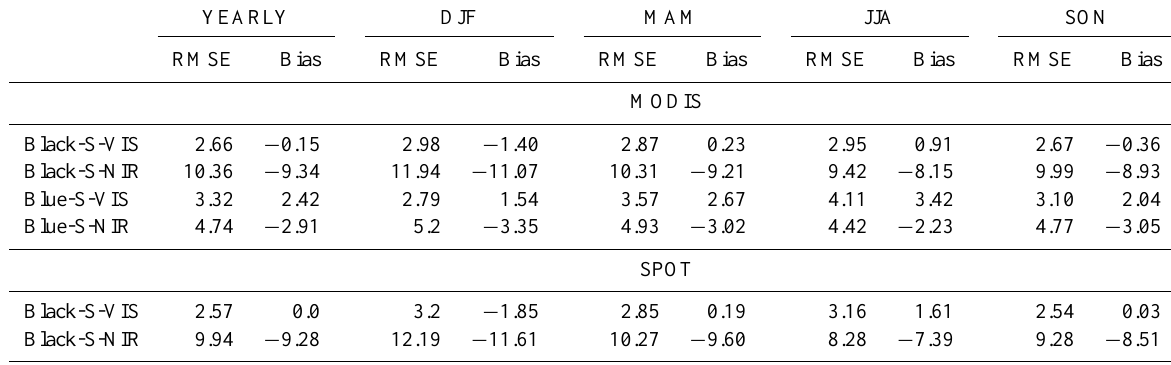
Table 6. Same as in Table 3 but for the PSALB_20 experiment.